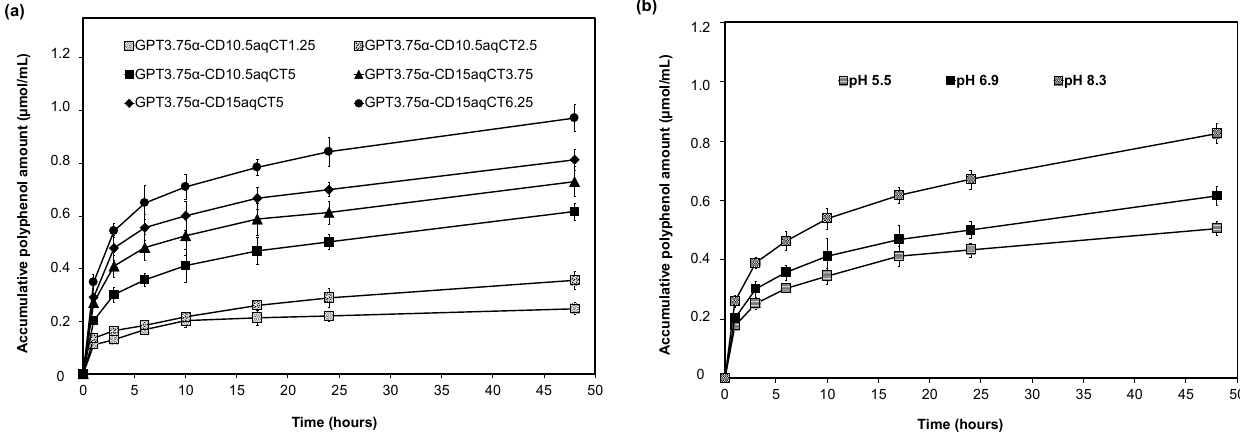
Figure 3. The cumulative polyphenol release profiles: released polyphenols from various GPT/ α -CD/aqCT gels in DIW (pH 6.9) ( a ), released polyphenols from GPT3.75 α -CD10.5aqCT5 gel under different pH ( b ).